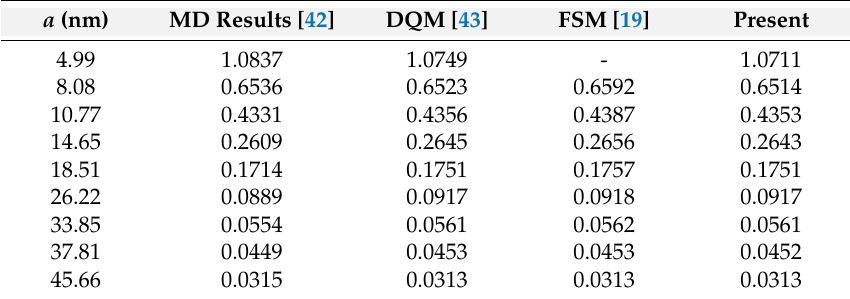
Table 3. Comparative evlauation of the critical buckling load (nN/nm) for isotropic square graphene sheet under biaxial compression